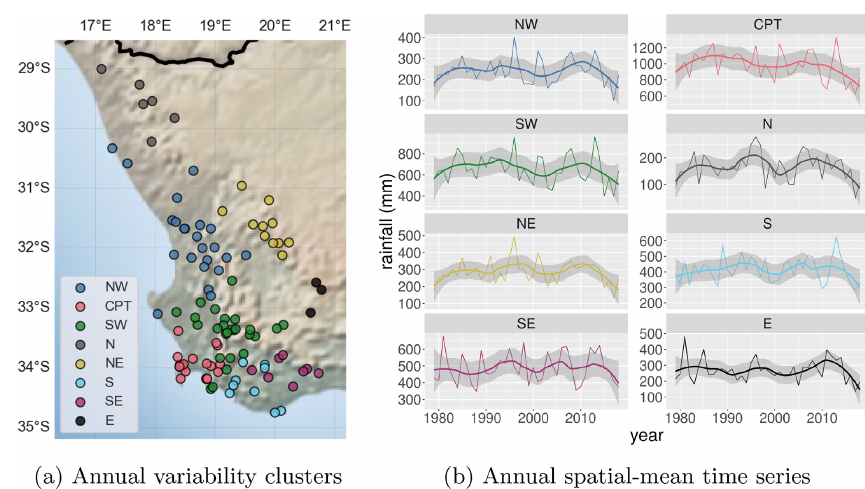
Figure A2. Figure 4a and c of Conradie et al. (2022): map and corresponding mean annual time series of annual variability clusters.